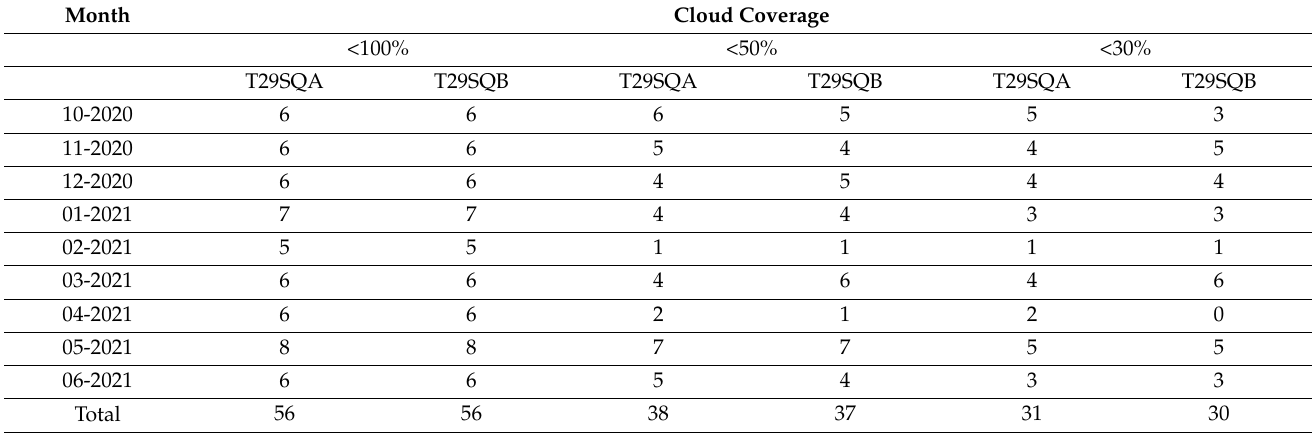
Table 3. Available Sentinel-2 images from October 2020 to June 2021 for different cloud